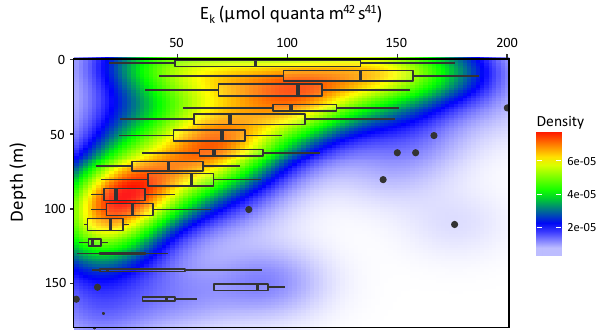
Figure 10. Density plot and box plots showing variation in the photoadaptation parameter ( E k ) with depth for research cruises fo- cussed on the oligotrophic gyres (DCM, AMT6, AMT15, AMT20 and AMT22). Middle horizontal line of boxplot represents the me- dian value and lower and upper boundaries correspond to the first and third quartiles and the length of the whiskers is 1.5 times the inter-quantile range of the boundary. Heat map indicates probabil- ity density estimates. Filled circles denote